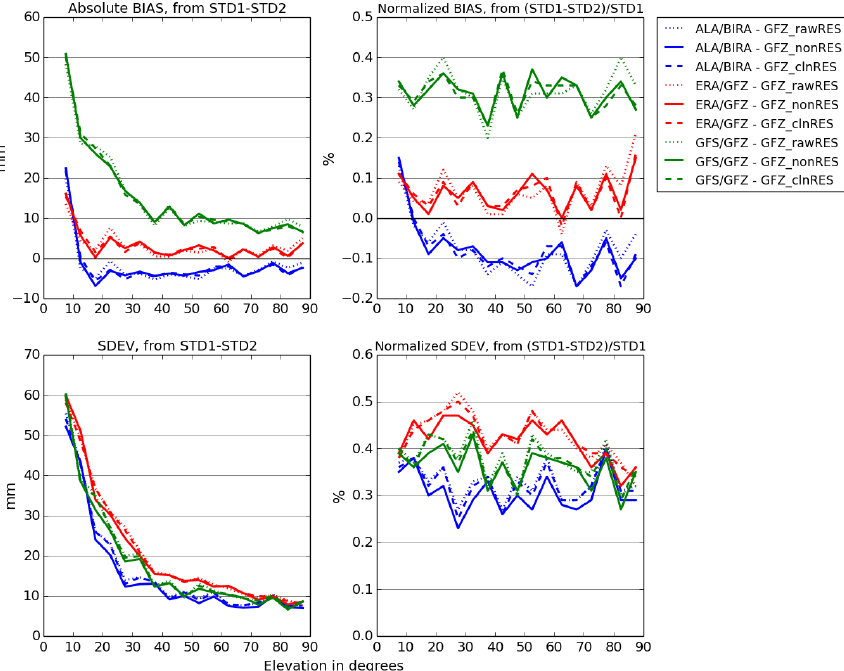
Figure 9. Comparison of NWM-based solutions (ALA/BIRA, ERA/GFZ and GFS/GFZ) against GNSS GFZ solution at station POTS, in the slant direction.